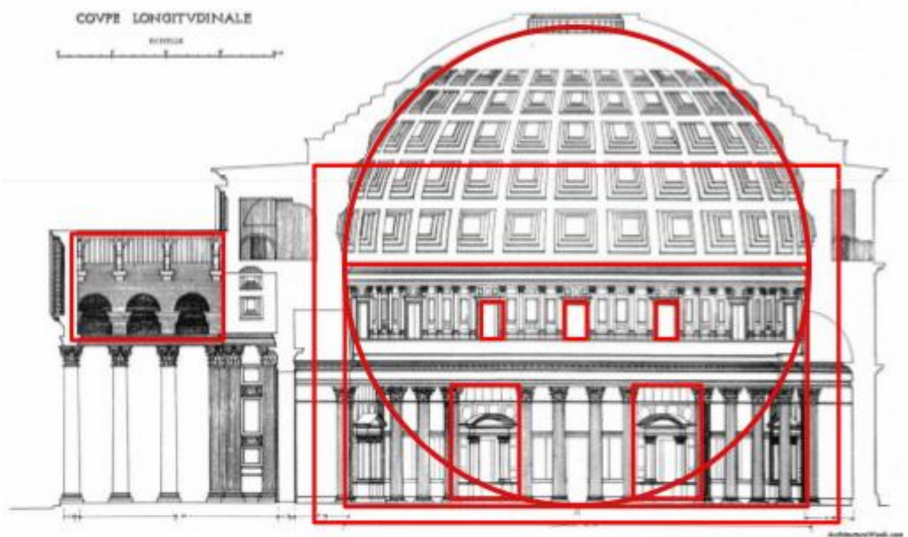
Figure 18. Roman Pantheon. Sectional golden